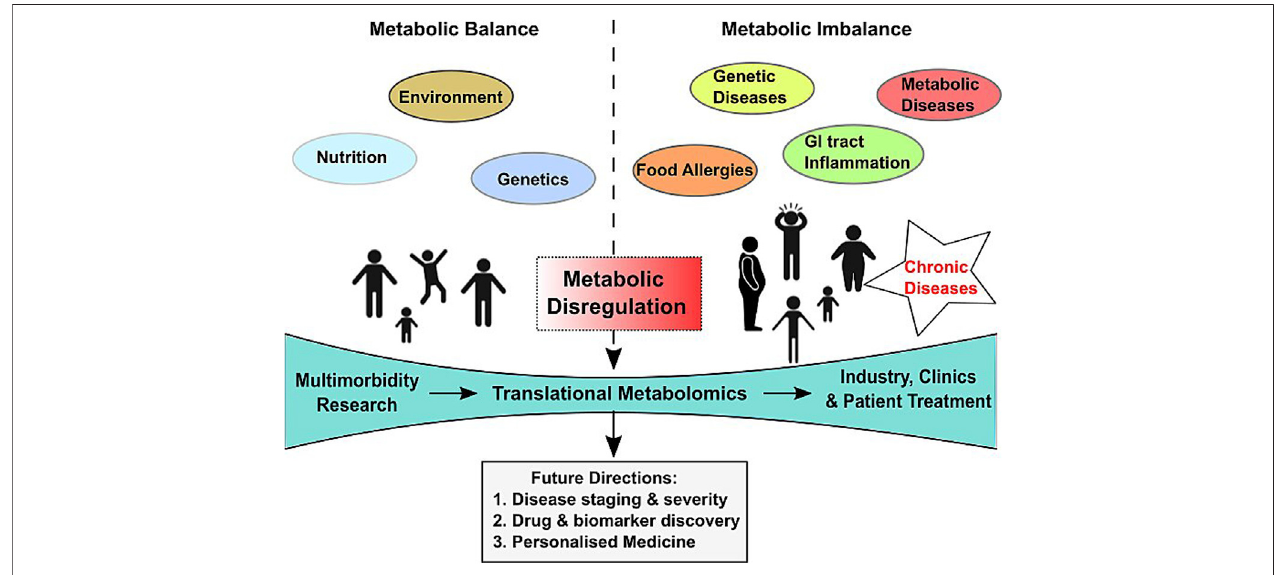
FIGURE 2 | Scheme depicting in fl uencing factors, model of care, and future directions of translational metabolomics in multimorbidity diagnosis and